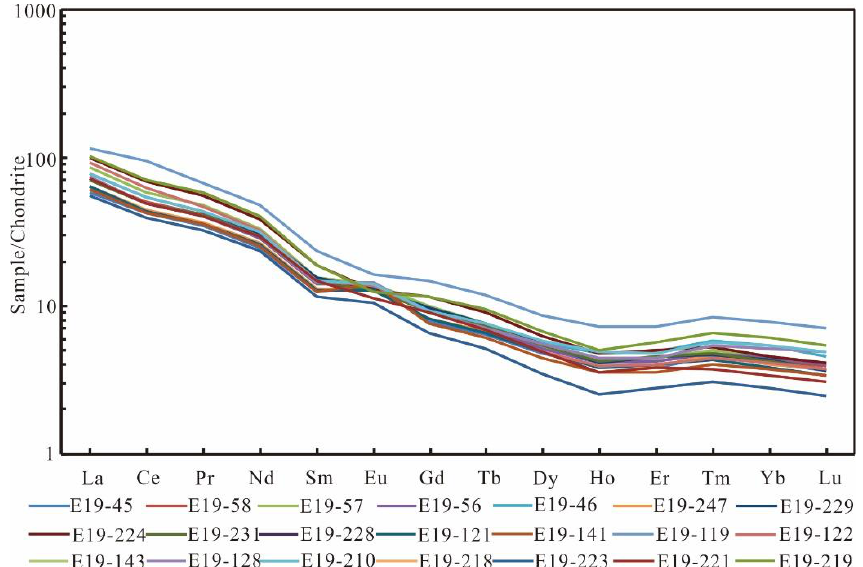
Figure 6. Chondrite-normalized REE diagram for the Zhiluo Formation sandstones. Standardized chondrite data is quoted from Taylor and McLennan [34].